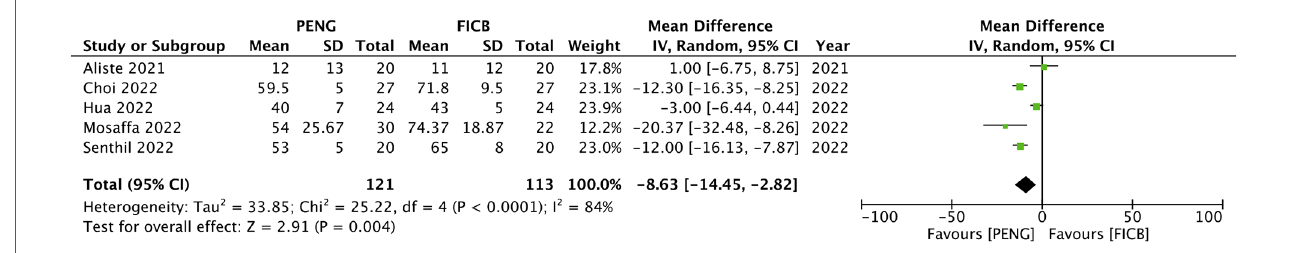
FIGURE 3 Meta-analysis of 24 h total analgesic consumption between PENG and FICB groups.